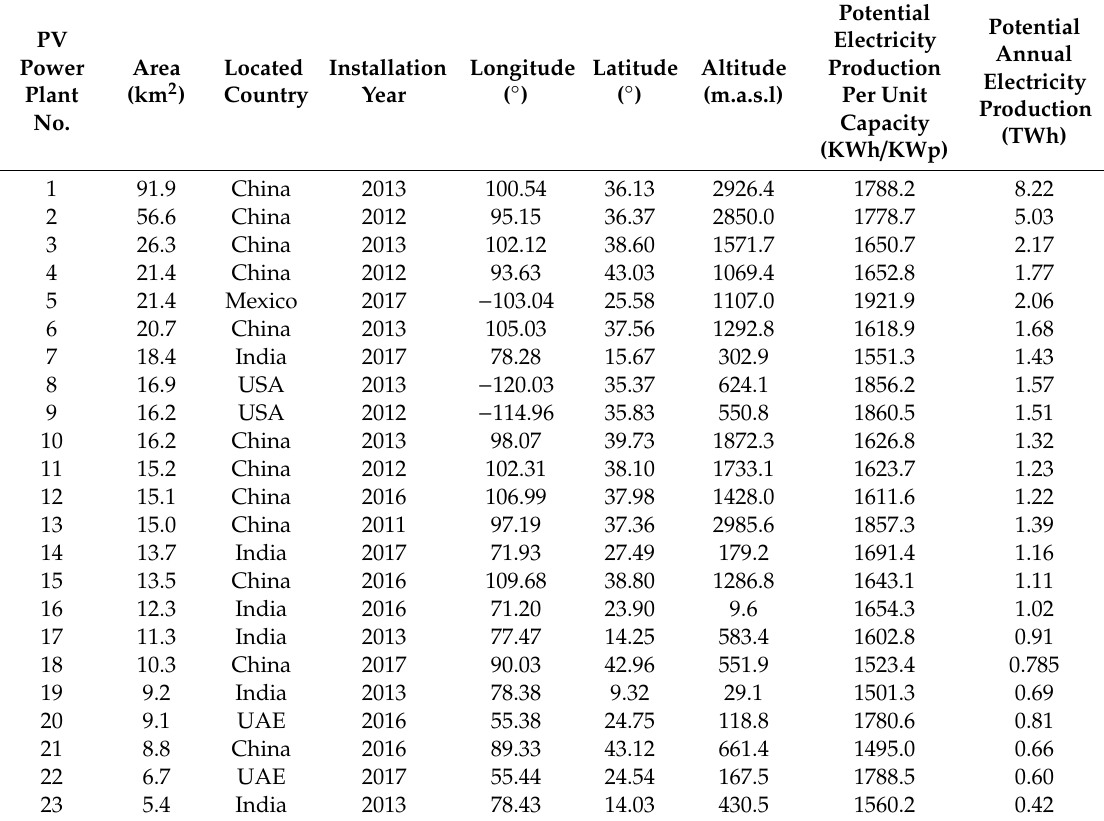
Table 1. The descriptive statistics of the photovoltaic (PV) powerplants. The potential PV electricity production per unit capacity was obtained from the Global Solar Atlas